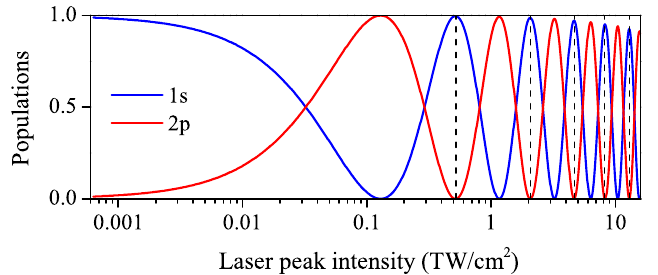
Figure 2. (Color online) Final populations of the ground state (1s) and the excited 2p state of hydrogen at the end of the process of its resonant two-photon ionization, as functions of the laser peak intensity. The results obtained using the Gaussian, half-Gaussian and rectangular pulses (Equations (7)–(9)) of carrier frequency ω = 0.375a.u. with τ = 30fs, τ (cid:48) = 60fs and τ (cid:48)(cid:48) = 26.5868fs practically coincide and they are represented by common lines. The vertical dashed lines indicate the peak intensities at which an integer number of Rabi cycles during the pulse is completed.